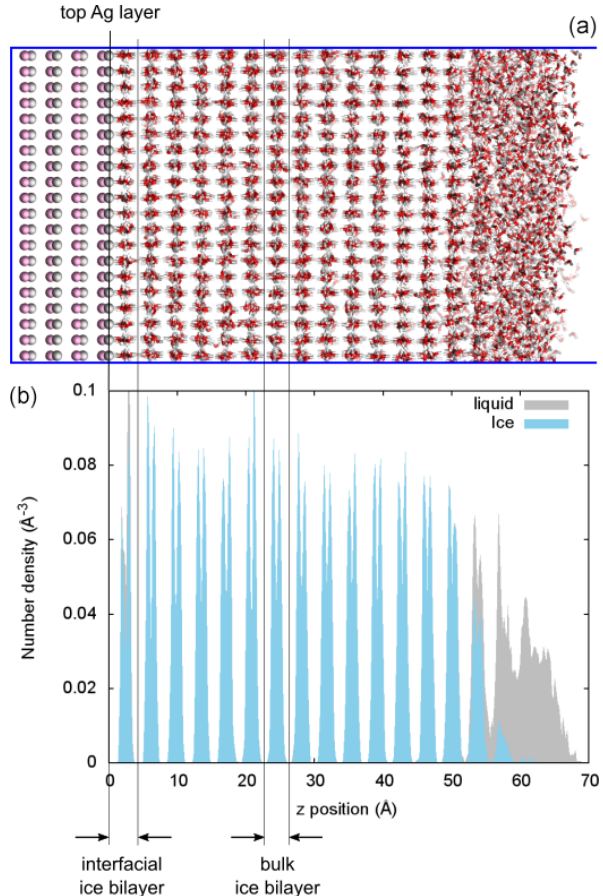
Figure 2. (a) Snapshot of a simulation of ice growing in a film of water on a flat Ag-terminated AgI(0001) surface. Ag and I are shown in silver and pink, respectively, and water molecules are shown as red and white sticks. (b) Number density profiles of wa- ter molecules along the z axis, perpendicular to the AgI surface. Ice and liquid water are shown in blue and gray, respectively, and the widths of an ice bilayer at the interface and in the bulk are indicated by black